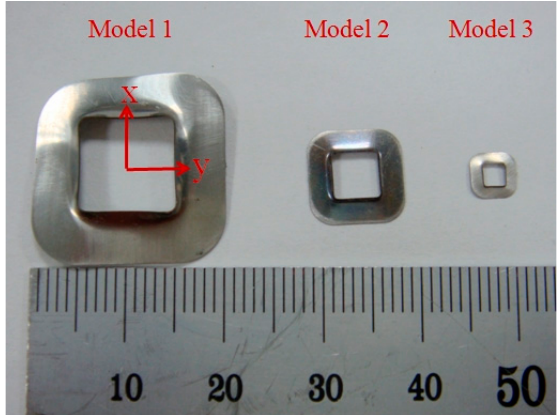
Figure 5. Three stainless steel specimens after punching and rebound. 4.1. Influence of the Fillet Radius of the Hole on the Drawing Process Process analysis was carried out for changes in fillet radius of the hole in the sample sheets. The radius of the fillet of the hole (Br) in the different model blanks is shown in Table 6. The material parameter values were corrected by a scale factor and the material was regarded as being isotropic. Table 6. The fillet radius and related parameters of the hole in the stainless steel sheet (unit: mm). Model No.